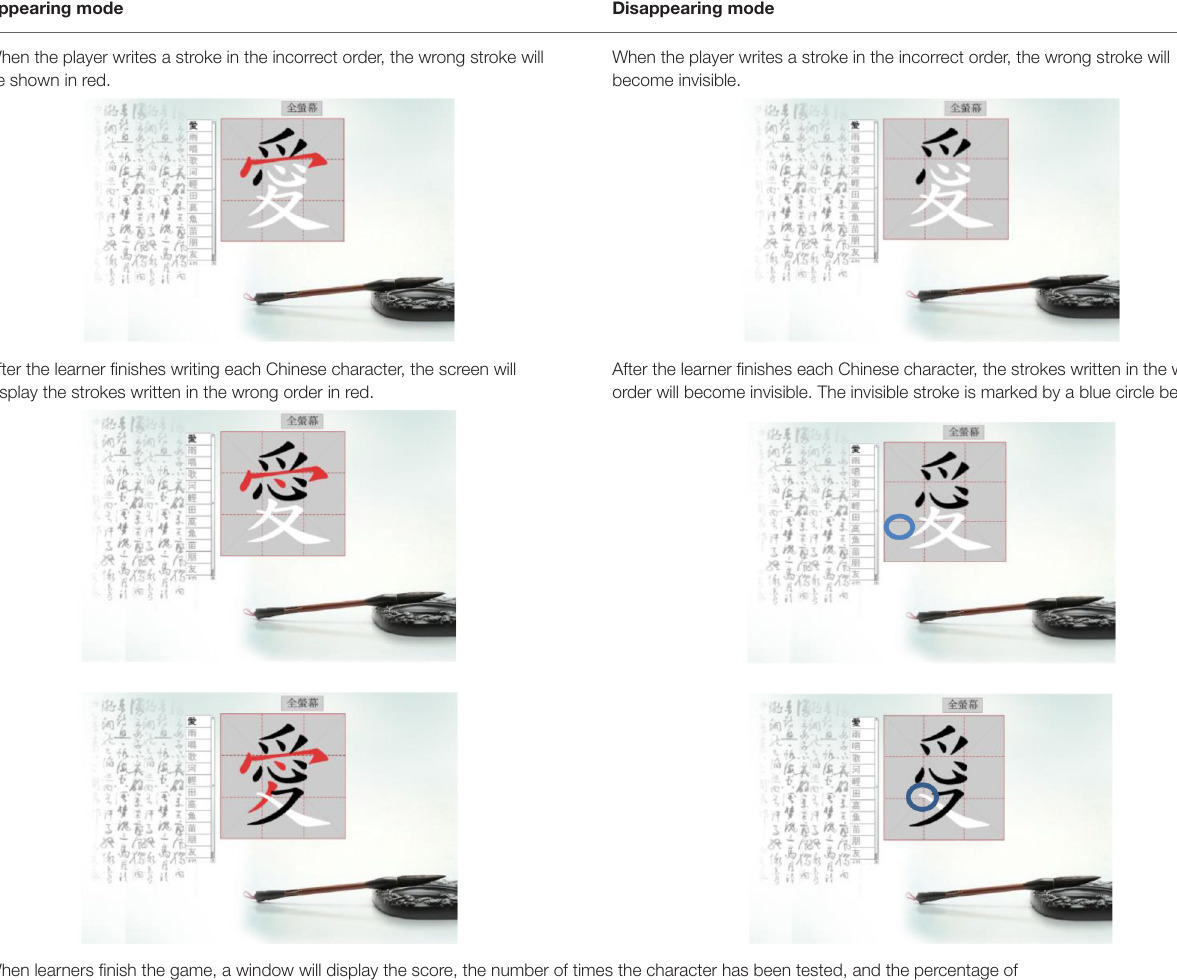
TABLE 1 | Comparison of the COS game modes. Appearing mode Disappearing